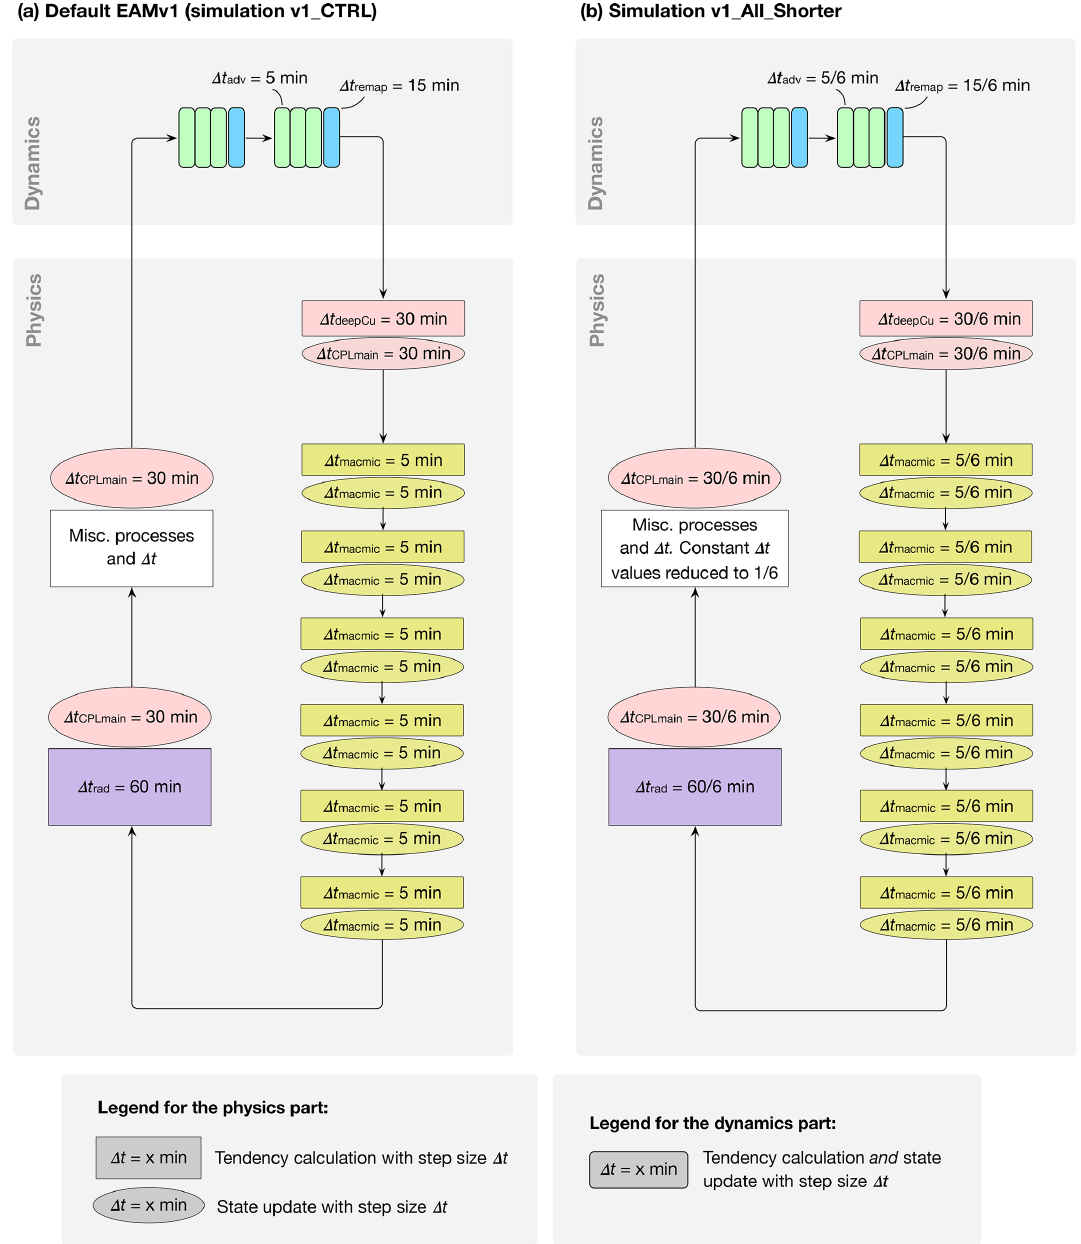
Figure 2. (a) Time step sizes used by the default EAMv1 at 100km resolution, corresponding to simulation v1_CTRL in this paper. Different colors indicate different step sizes. Shapes filled with the same color use the same step size. Further details can be found in Sect. 2.1. (b) Similar to (a) but for the simulation v1_All_Shorter (see Tables 1 and